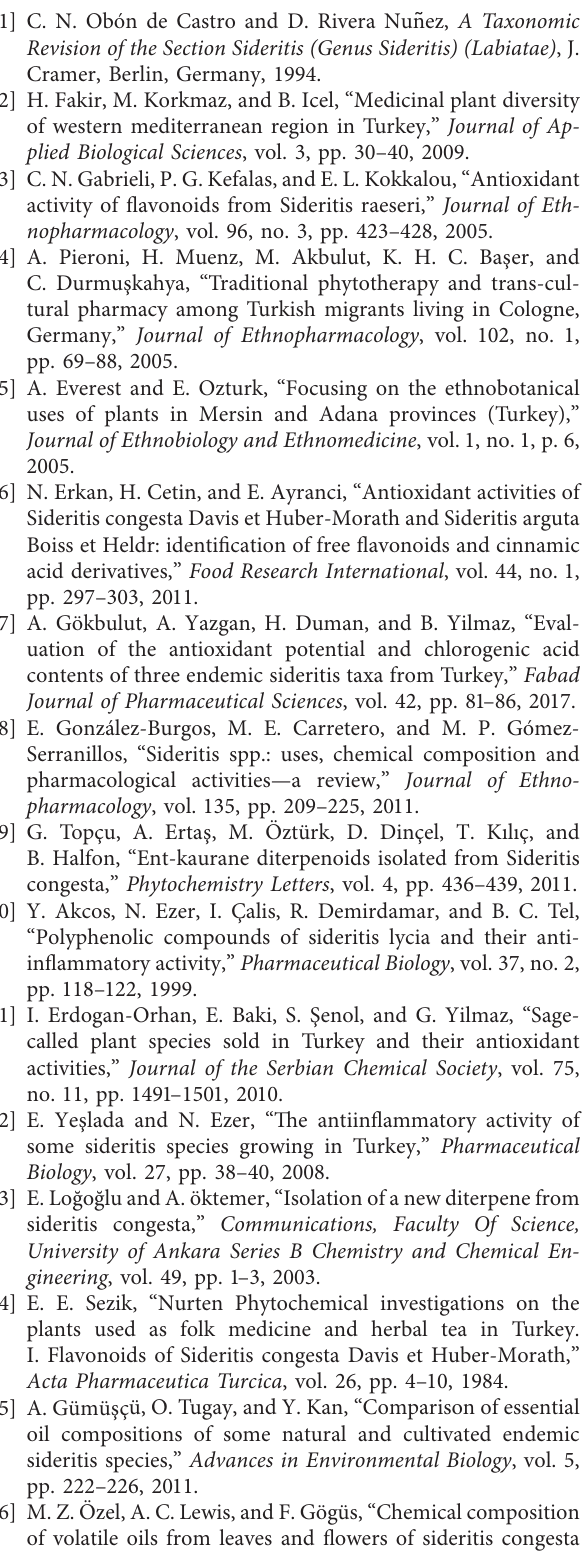
3 . Fig. S4 . UV-chromatogram of stachyspinoside 1 fraction. Fig. S5 . TIC-MS of stachyspinoside 1 fraction. Fig. S6 . Mass spectrum and fragmentation of stachyspinoside 1 . Table S1